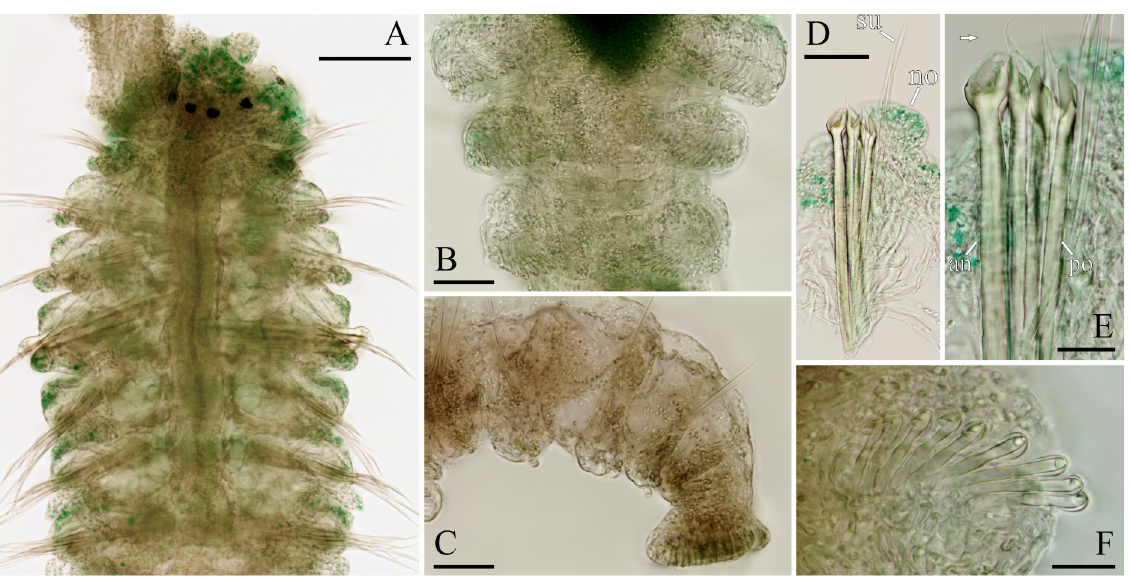
Fig. 11. Adult morphology of Pseudopolydora auha sp. nov., holotype (MIMB 40907), formalin-fixed and stained with MG). A . Anterior end, dorsal view. B . Posterior chaetigers, ventral view. C . Posterior end, left lateral view. D . Notopodium of chaetiger 5. E . Notochaetae of chaetiger 5. F . A series of hooded hooks from neuropodium of chaetiger 12. Abbreviations: arrow showing the direction towards the inside of the U-shaped row of spines of chaetiger 5; an = anterior-row spine from notopodium of chaetiger 5; no = notopodial postchaetal lamella; po = posterior-row spine from notopodium of chaetiger 5; su = dorsal superior capillary chaetae. Scale bars: A = 100 µm; B–D = 50 µm; E–F = 20